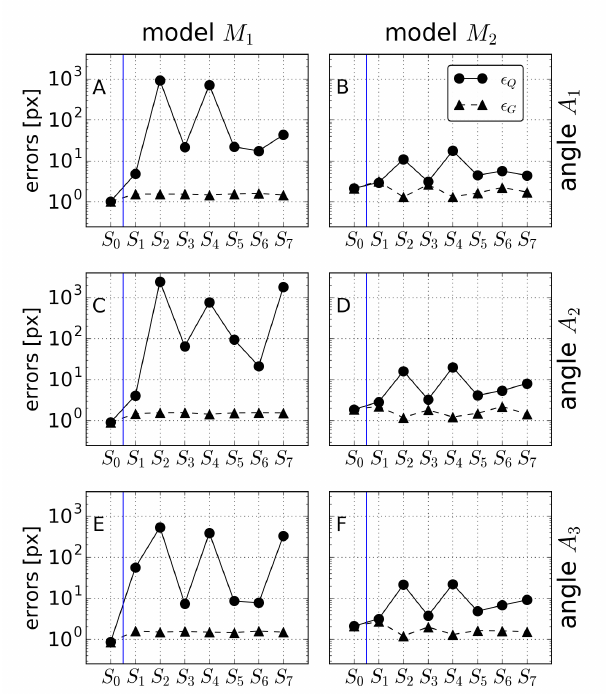
Figure 9. Errors (cid:101) Q and (cid:101) G for angle A 1 with τ ∼ 55 ◦ ( A , B ); A 2 with τ ∼ 40 ◦ ( C , D ); and A 3 with τ ∼ 15 ◦ ( E , F ); and for models M 1 ( A , C , E ) and M 2 ( B , D , F ) as a function of the GCP calibration set ( S 0 to S 7 ).